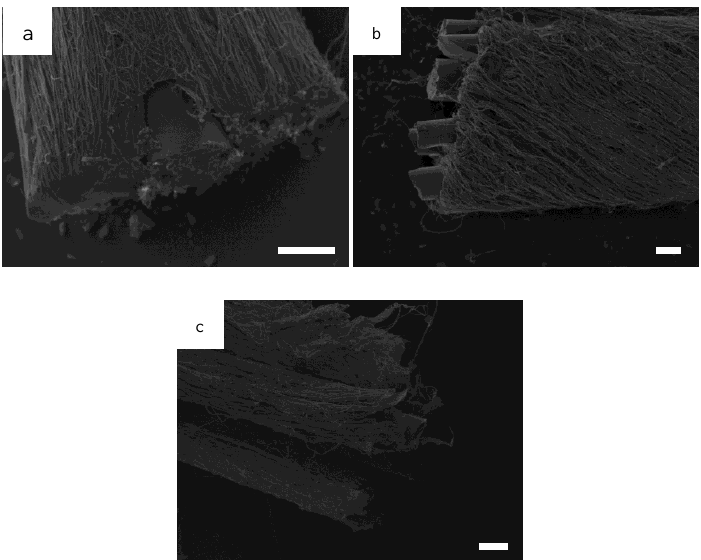
Figure 3. SEMs of ( a ) a ~150 µ m diameter glass fiber wrapped in electrospun nanofibers to a total of ~500 µ m diameter; ( b ) a bundle of eight ~200 µ m diameter homologous and uniform synthetic osteons (HOUSteons) wrapped together to a total diameter ~800 µ m, with ( c ) the outer layer peeled back. Scale bar is 100 µ m.